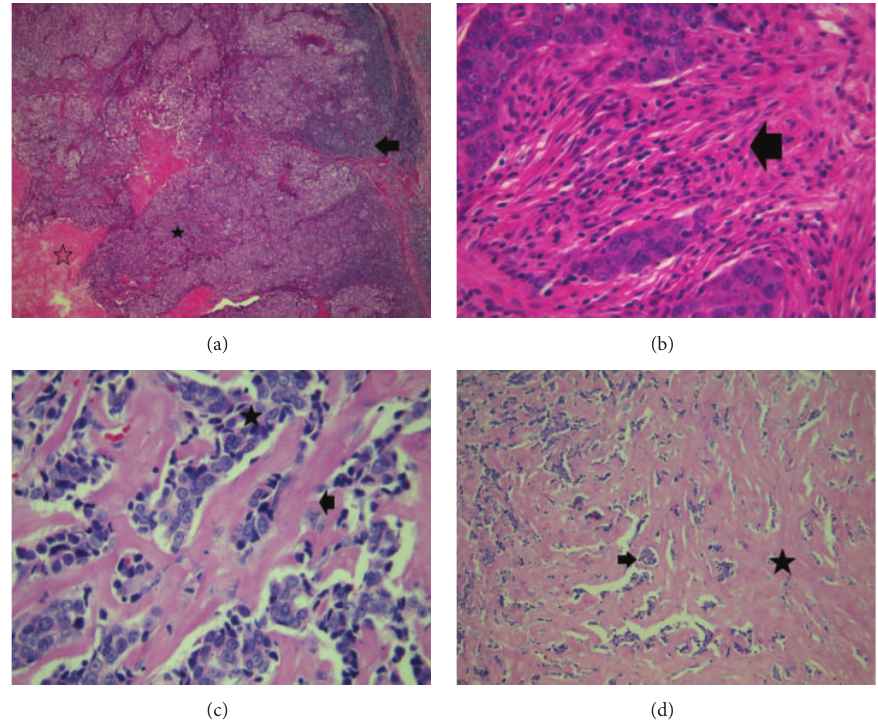
Figure1: Stromaevaluation forER − PR − HER2 − (TNBC)and ER+PR+HER2 − breast cancer subtypes: (a)TNBCmammarycarcinoma (40x): black star, viable tumor, hollow star, necrosis, and black arrow, heavy inflammation; (b) TNBC mammary carcinoma (400x): black arrow, desmoplastic stroma with moderate inflammation; (c) ER+PR+HER2 − mammary carcinoma (400x): black arrow, fibrohyaline stroma, and black star, viable tumor; (d) TNBC mammary carcinoma (40x): black arrow, viable tumor, and black star, desmoplastic